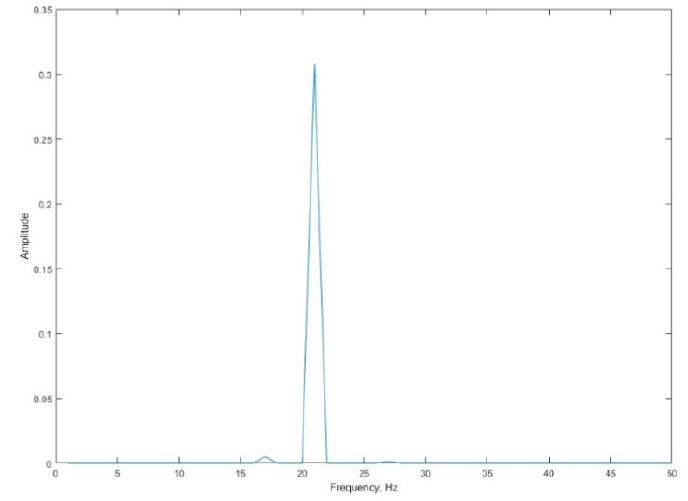
Figure 15. NC spectrum of mono-harmonic signal with 20.3 Hz.